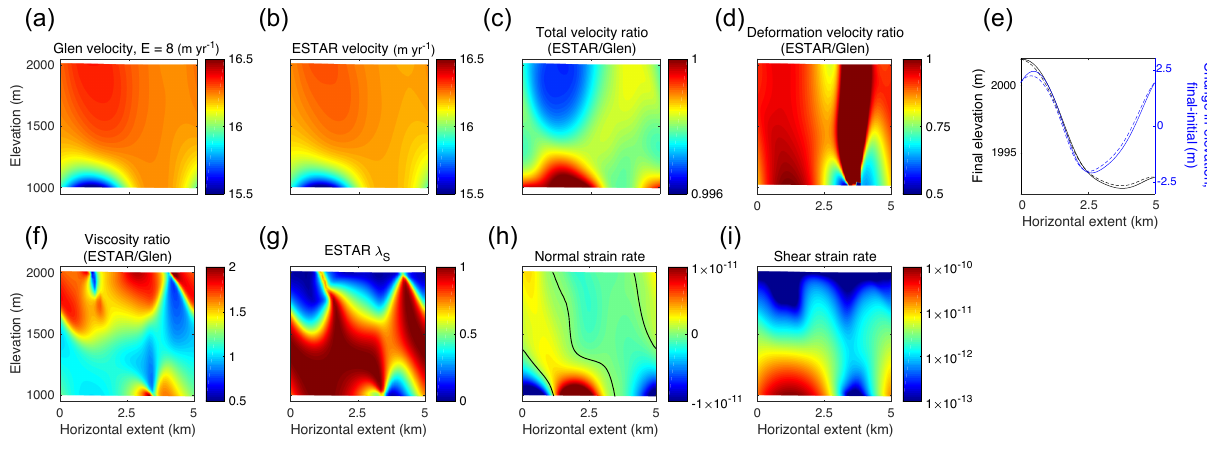
Figure 9. As for Fig. 8, but with L =